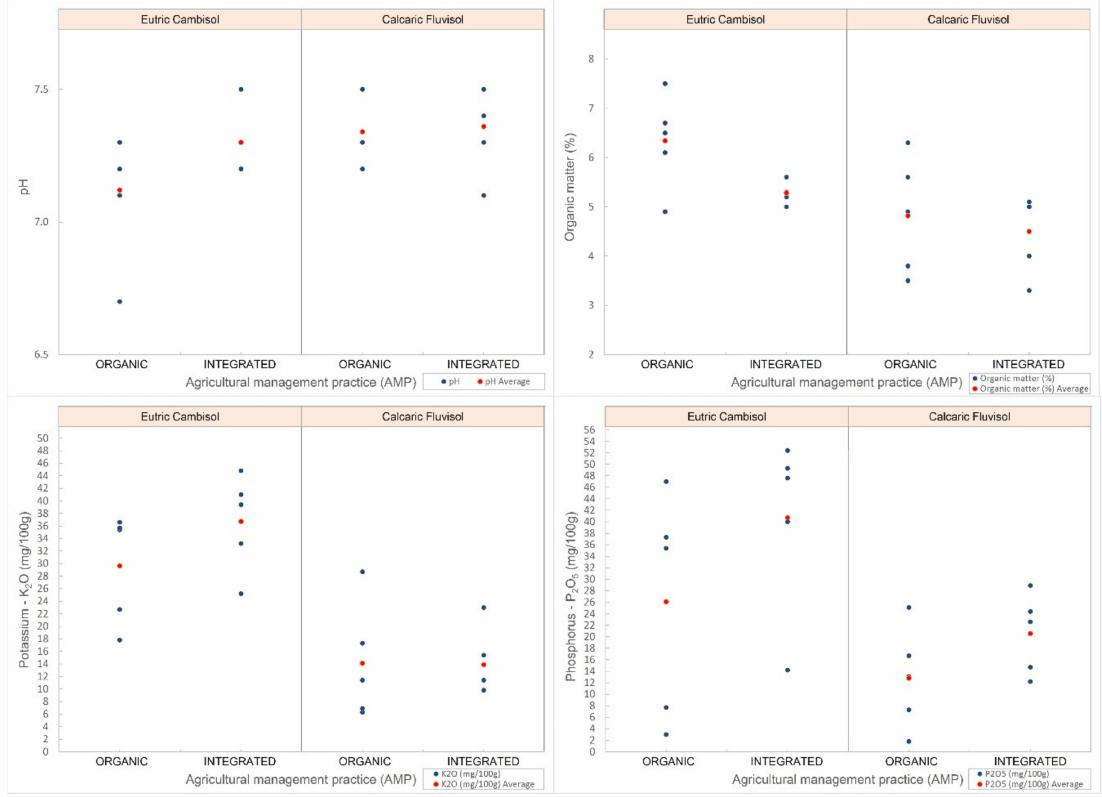
Figure 5. Graphic presentation of the measured soil pH (CaCl 2 ), organic matter, potassium (K 2 O), and phosphorus (P 2 O 5 ) of sampled fields concerning the agricultural management practice type and soil type (red dots represent the mean of the blue